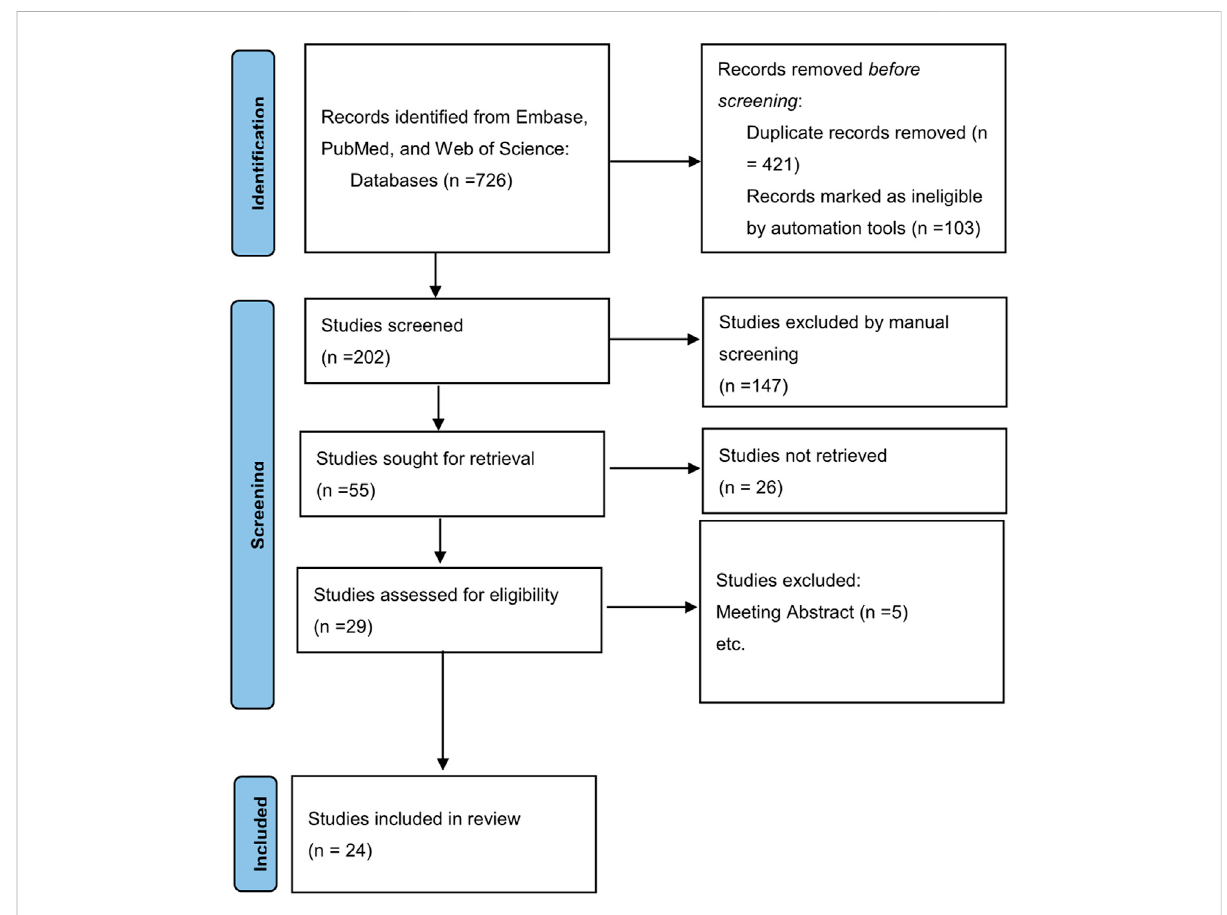
FIGURE 1 A fl ow diagram demonstrating the search strategy and study selection process for this